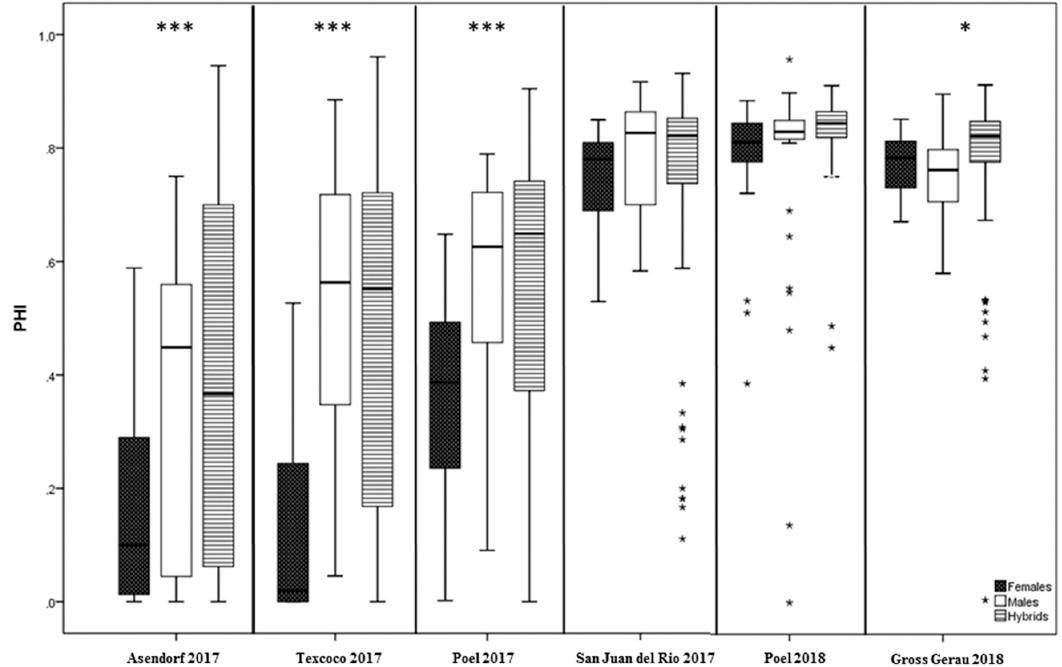
Figure 2. Boxplots showing the panicle harvest index (PHI) of female lines, male lines and their hybrids Figure 2 Boxplots showing the panicle harvest index(PHI) of female lines, male lines and their hybrids 208 at the six field environments. * Significant at 0.05 level; ** Significant at 0.01 level; *** Significant at 0.001 at the six field environments. *Significant at 0.05 level; **Significant at 0.01 level; ***Significant at 0.001 209 level. Significance levels refer to di ff erences between the group hybrids and lines (females and level. Significance levels refer to differences between the group hybrids and lines (females and males). 210